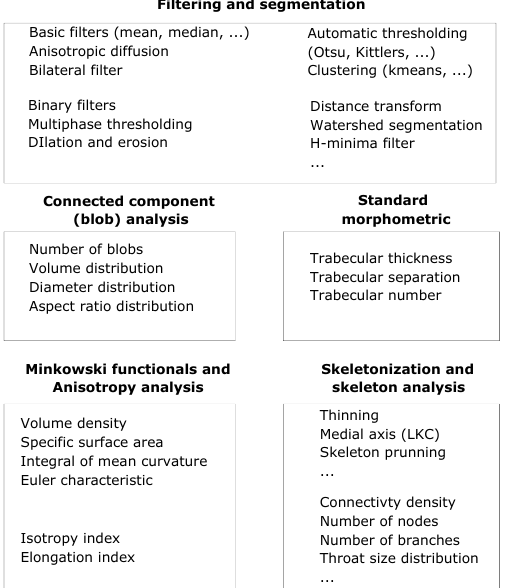
Figure 2. PyPore3D module architecture for quantitative analysis of 3D images. The modules used in the example applications are grouped in the